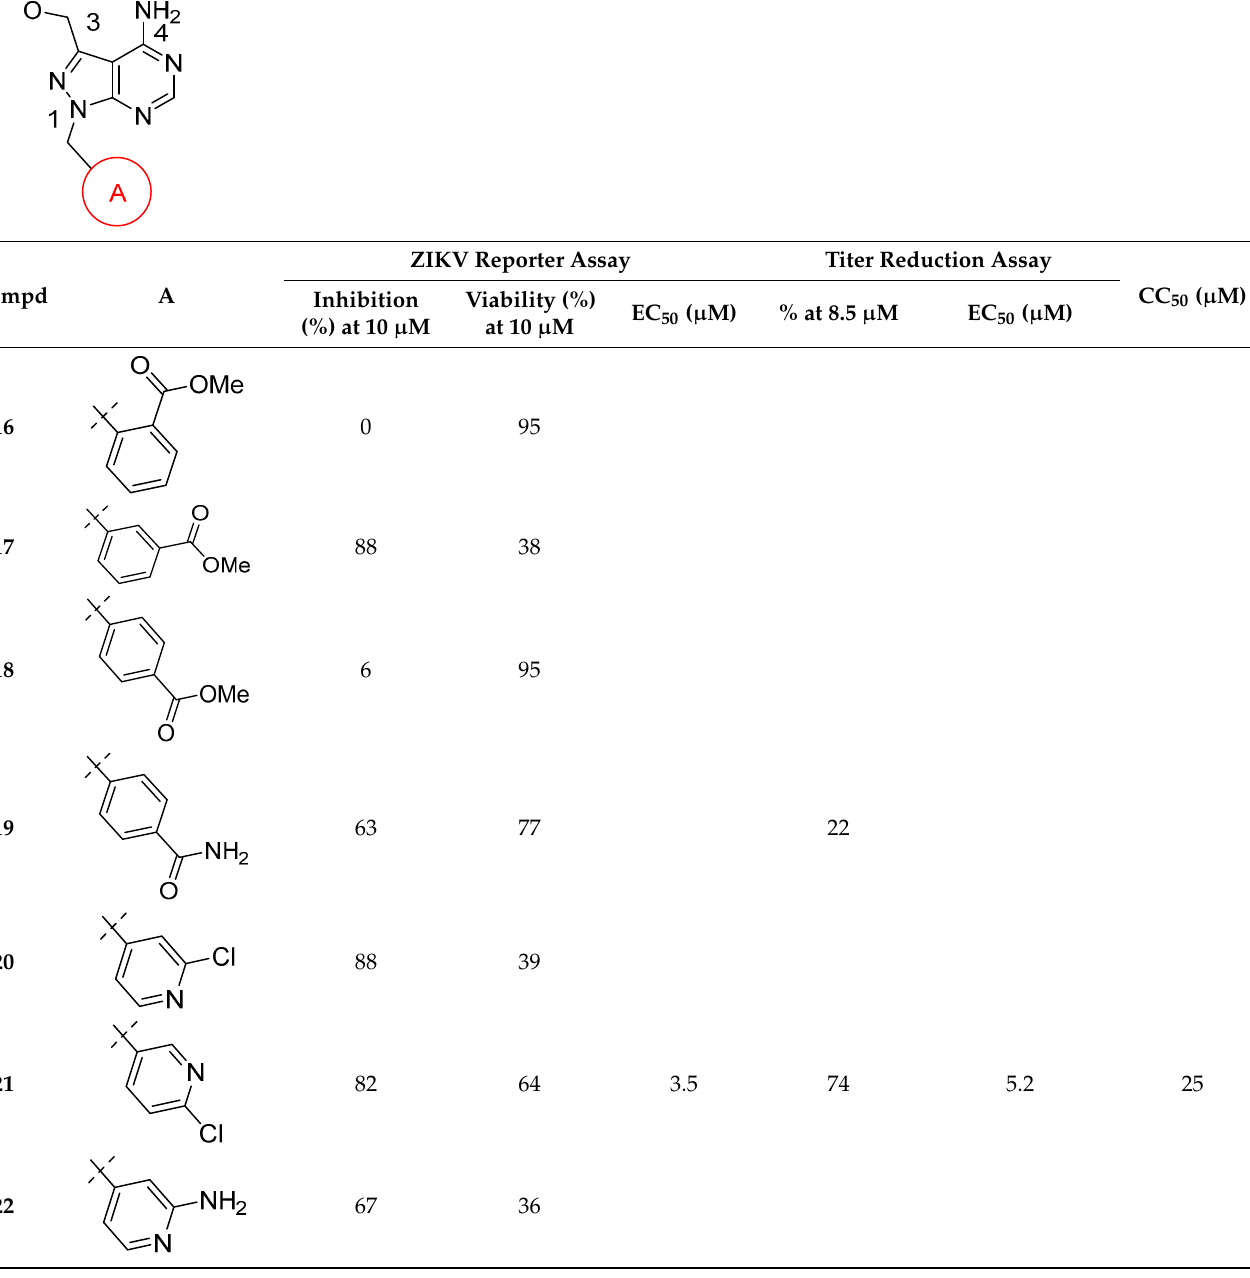
Table 2. Cont. Table 2. SAR study on ring A of 1 H ‐ pyrazolo[3,4 ‐ d]pyrimidin ‐ 4 ‐ amine